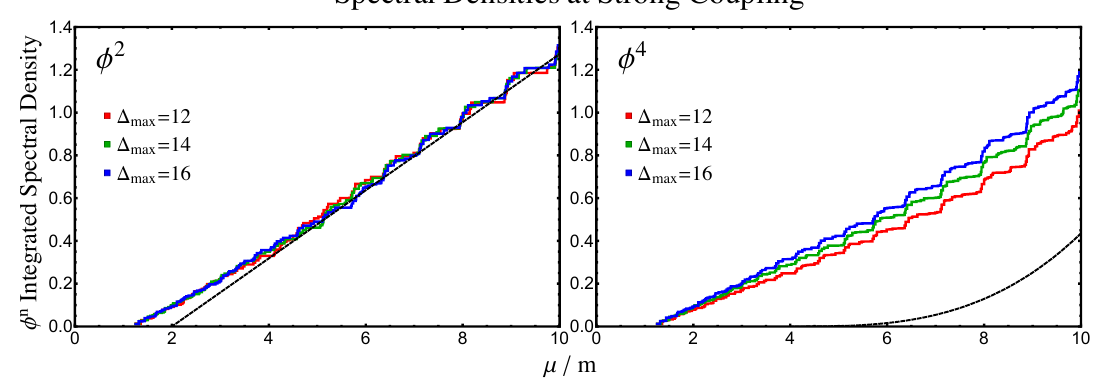
Figure 9 . Spectral density of φ 2 (left) and φ 4 (right) at nonperturbative coupling ¯ g ≈ 0 . 85 (where µ 2 -part. /m = 1 . 25 ). The dashed lines show the free theory result for comparison.